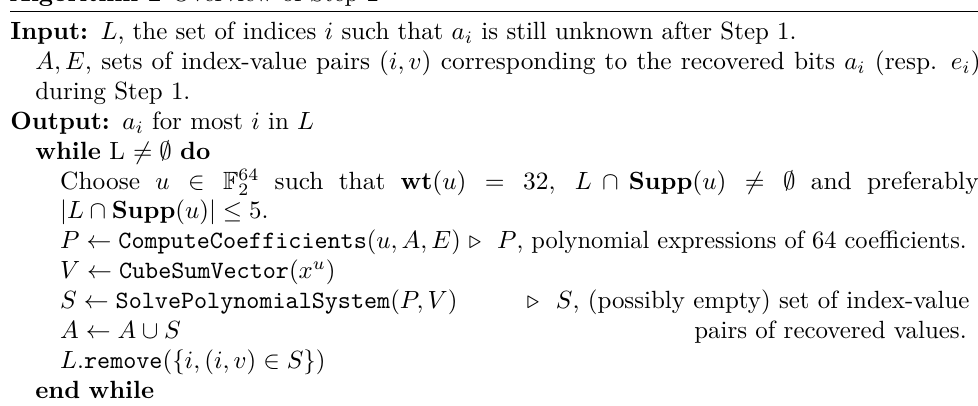
Algorithm 2 Overview of Step